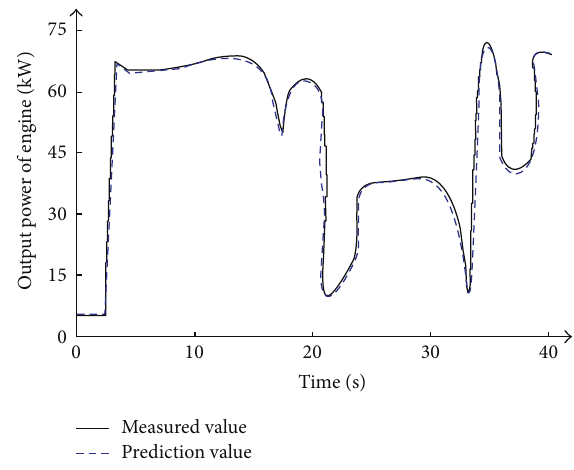
Figure 1: Performance predicting curve and measured curve of output power for engine.